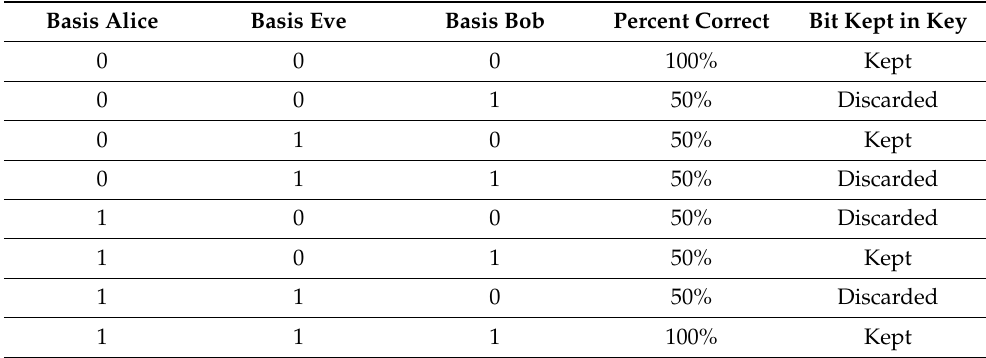
Table 5. An exhaustive list of encoding and measurement of a single qubit between Alice and Bob. Basis Alice Basis Eve Basis Bob Percent Correct Bit Kept in Key 0 0 0 100% Kept 0 0 1 50% Discarded 0 1 0 50% Kept 0 50% Discarded 1 0 0 50%